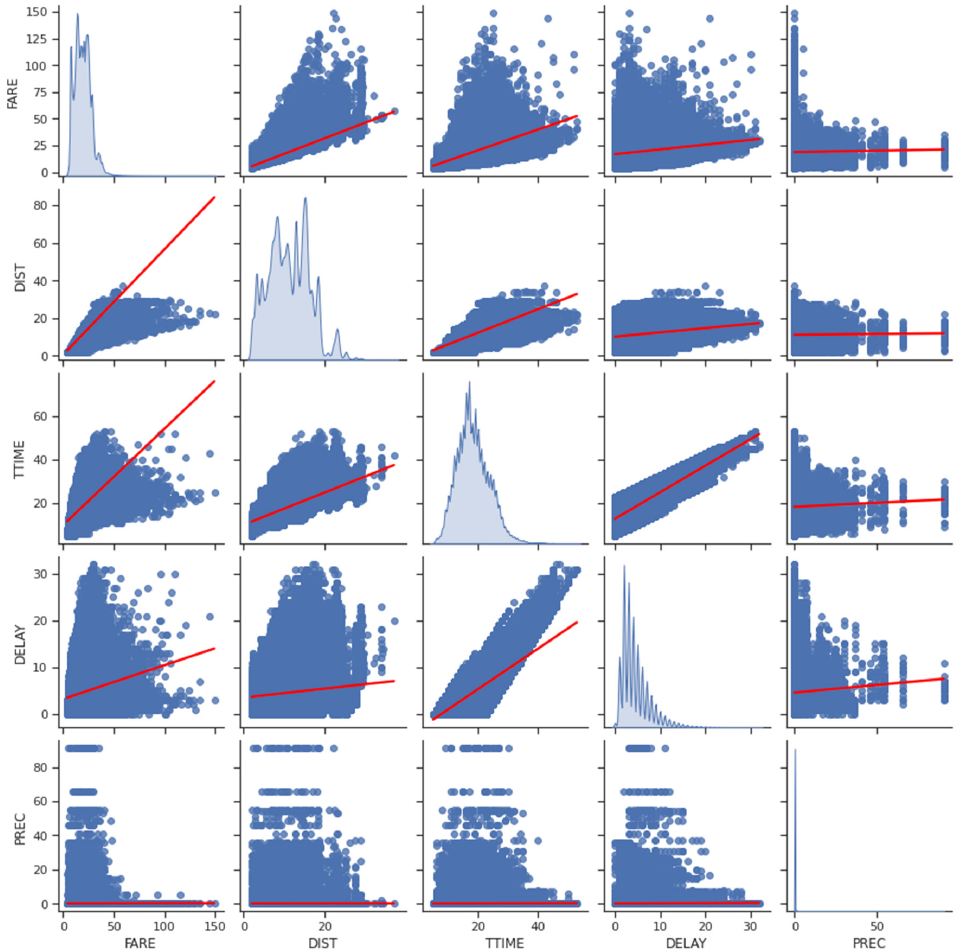
Figure 2. Pair plot of continuous variables. Notes: The points are in blue and linear regressions are in red, and the main diagonal represents kernel density estimates (KDEs).